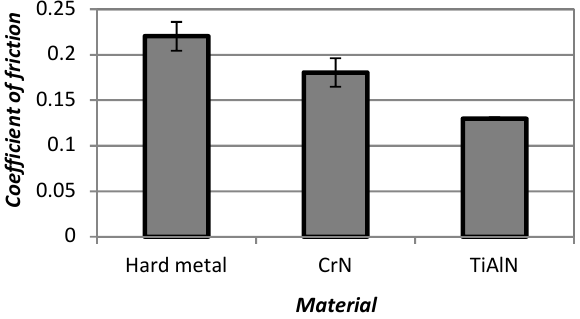
Figure 7. Coefficients of friction of the indenter and WC-Co specimens with and without PVD coatings.